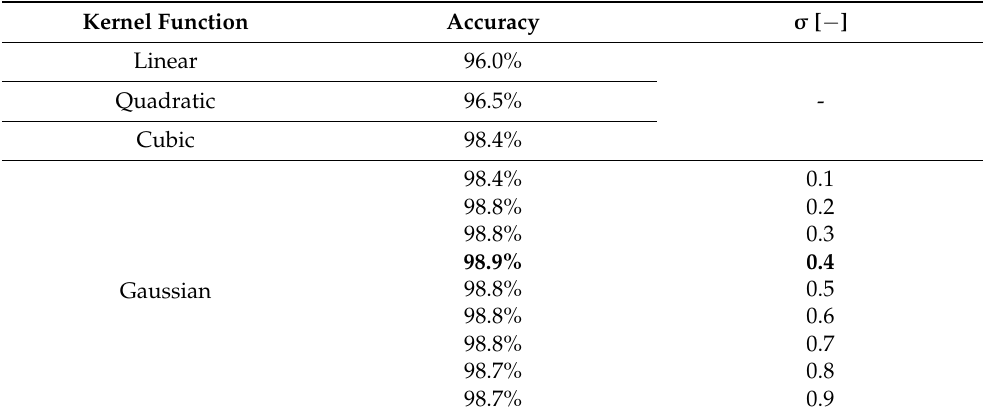
Table 2. The SVM classifier accuracy for different kernel functions. Kernel Function